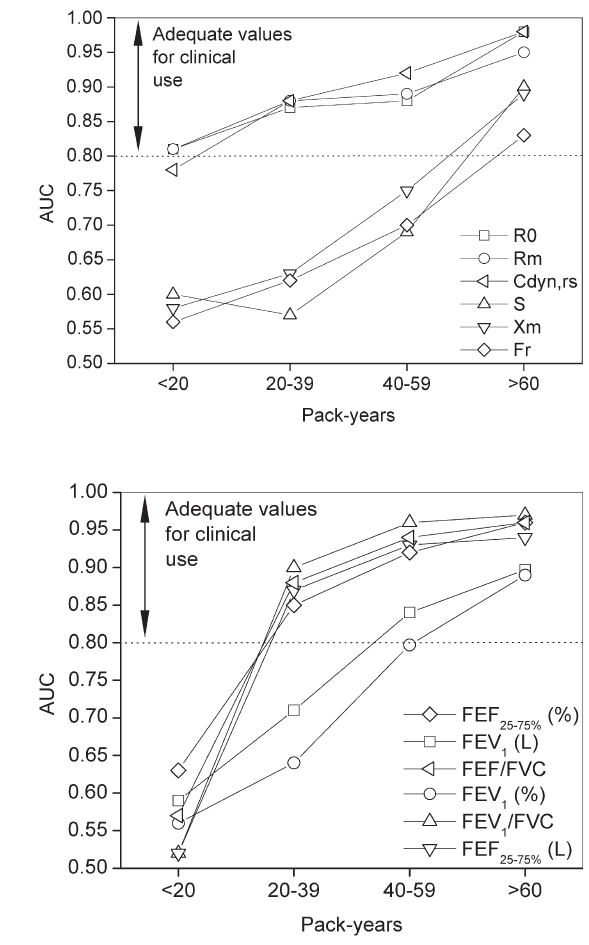
Figure 4 - Area under the ROC curve (AUC) of FOT (A) and spirometric (B) parameters obtained in all of the